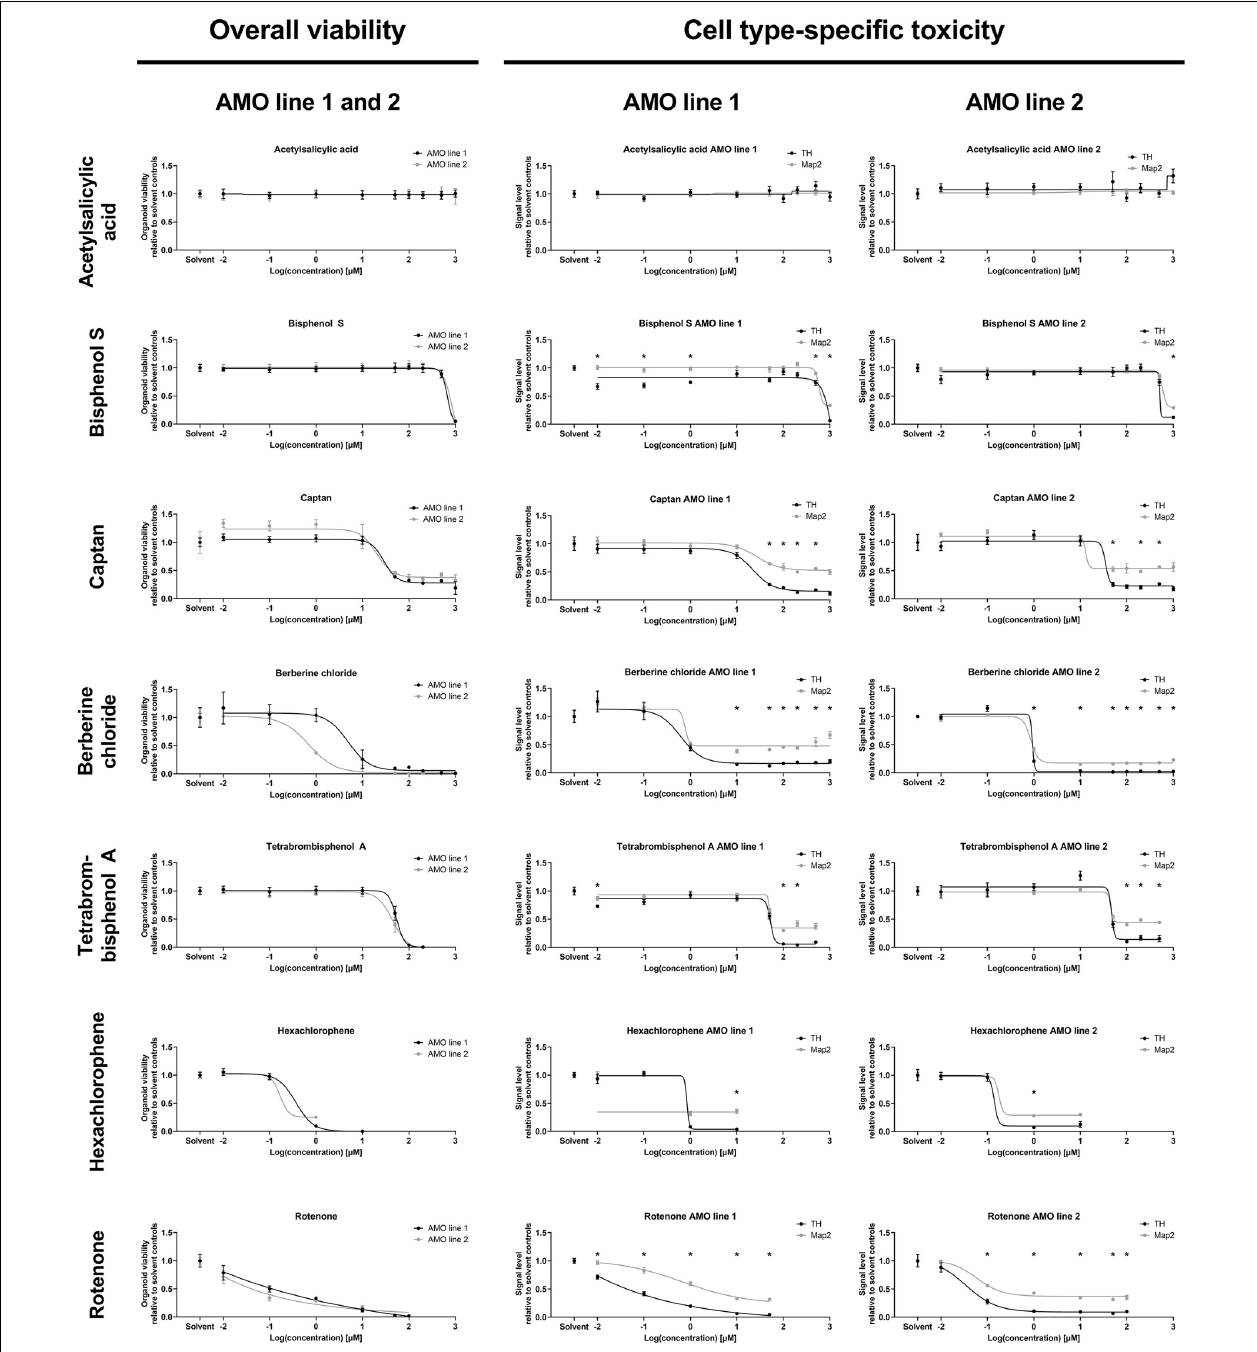
FIGURE 4 | Dose-response analyses of selected compounds confirmed the results of the primary screens. The analysis demonstrates the ability of our organoid-based workflow to detect and quantify typical dose-response behaviors induced by seven representative compounds. The left column lists ATP-based overall AMO viability data; the right two columns show high content imaging-based data for subpopulation-specific TH and Map2 content by cell line. The results are consistent with those of the primary screen at 100 µ M concentration (corresponding to “2” on the logarithmic scale) as well as the compound classifications (e.g., ASS as a negative control induces no significant changes at any of the tested concentrations). Depicted are the changes in signal level relative to the DMSO controls plotted against the log base 10 of the compound concentrations in µ mol/L. Data points are mean values ± SEM. We initially started with n = 8 organoids per condition; for exact sample numbers see Supplementary Table 3 . Statistical significance for the difference in Map2 and TH content was determined via multiple unpaired t -tests, and, after correction for multiple testing, we considered p adj < 0.05 as significant (*). For details on curve fitting as well as data and statistical analyses, see the “Materials and Methods”